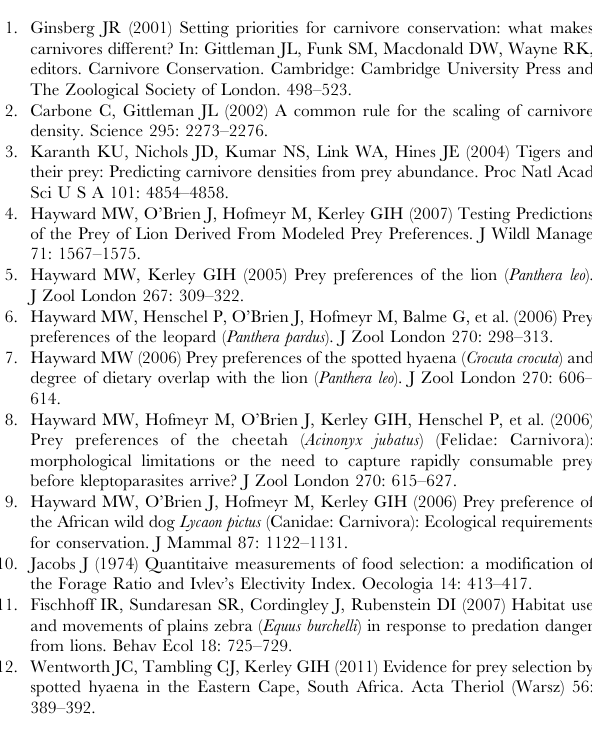
Table S1 Details of carnivore kill and prey abundance data used to calculate preferred and accessible prey weight ranges. The sources, location and timing of African studies, and the number of kills recorded in each, used by [5–9],